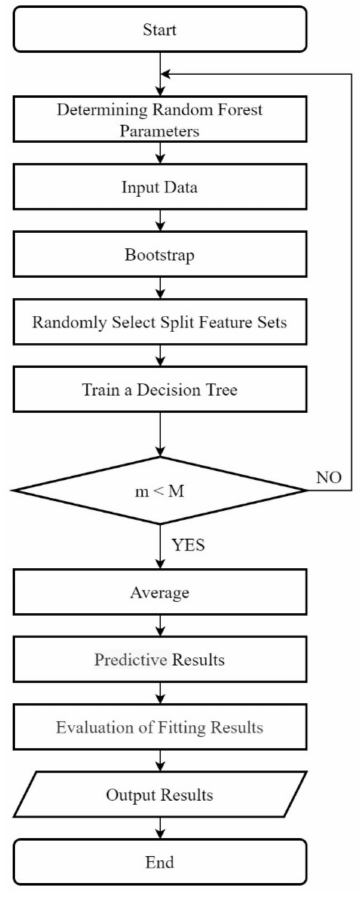
Figure 2. Random Forest Flow